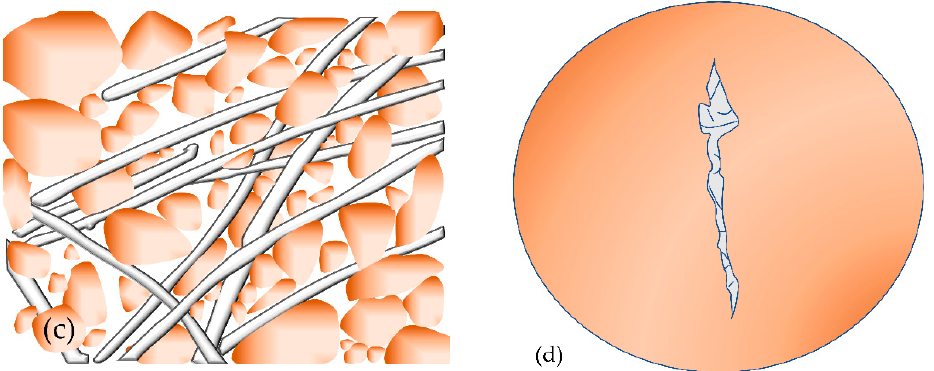
Figure 15. Fiber reinforcement mode, ( a , b ) one-dimensional reinforcement effect, ( c ) three-dimen- sional reinforcement effect, ( d ) “bridge”